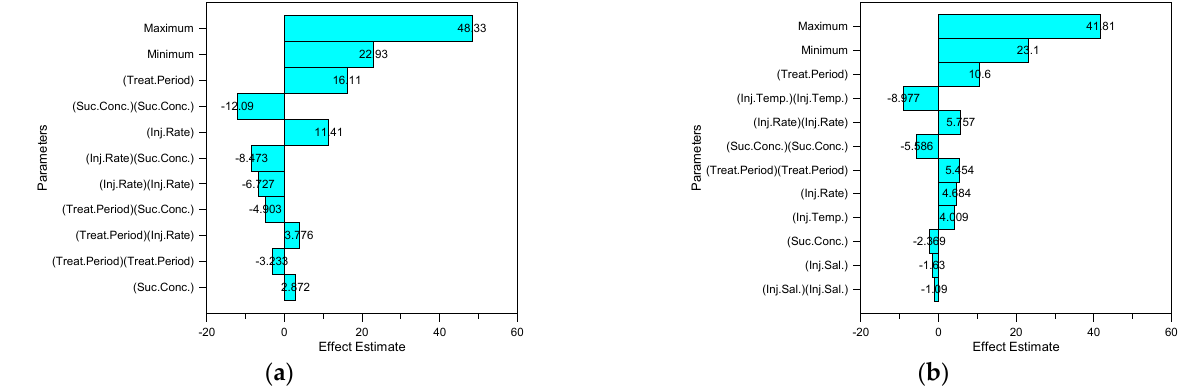
Figure 4. Sensitivity analysis for microbial enhanced oil recovery (MEOR): ( a ) ideal case and ( b ) real case.